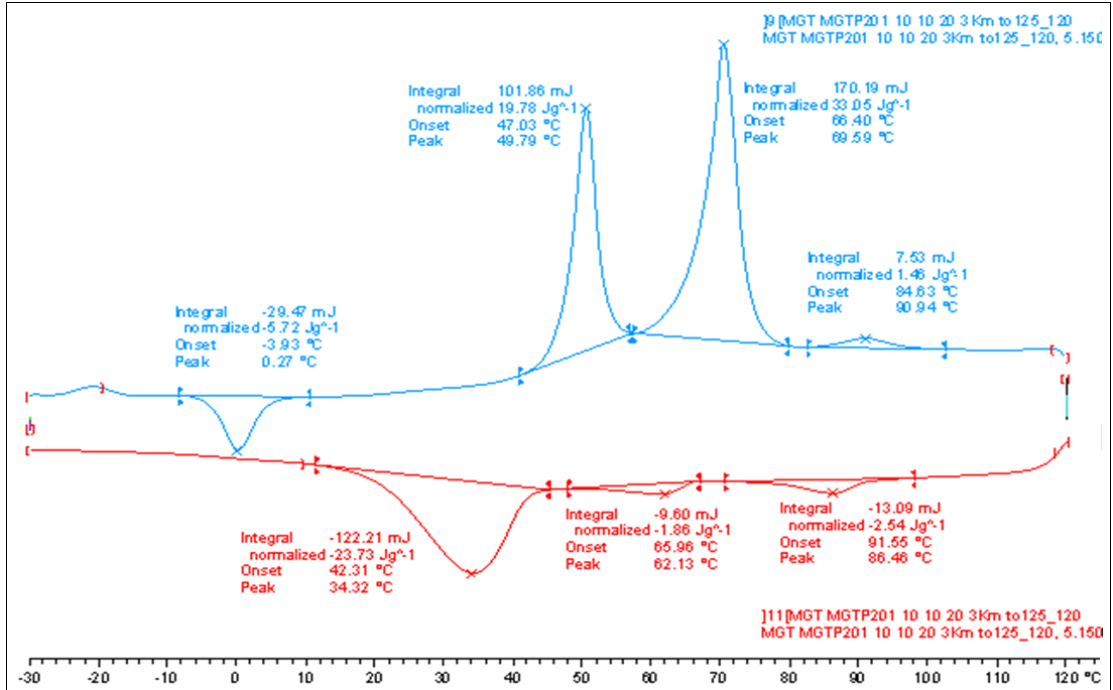
Figure 8. The nematic phase stability of 2 ranges on heating form −8.8 to 107.6 °C. The material was synthesized according to a reported method, and the results of the investigations of the LC phase behaviour are shown below [27]. Figure 6. DSC studies (10 K/min) of the binary mixture, MGTP201 (30% (w/w) 1 in 70% (w/w) CB_C9_CB ); the values are taken from the second heating and cooling scans. Cr 69.6 (33.05) N 90.9 (1.46) Iso; Iso 86.5 (−2.54) N 62.1 N Cr (°C); the numbers in brackets are the transition enthalpies in J∙g −1 .